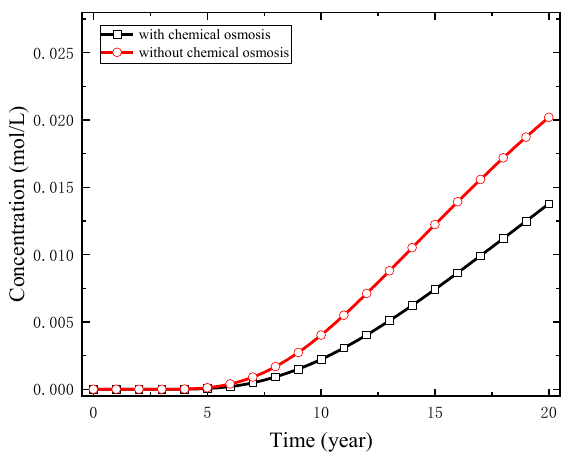
Figure 3: Distribution of solute concentration with time at the bottom